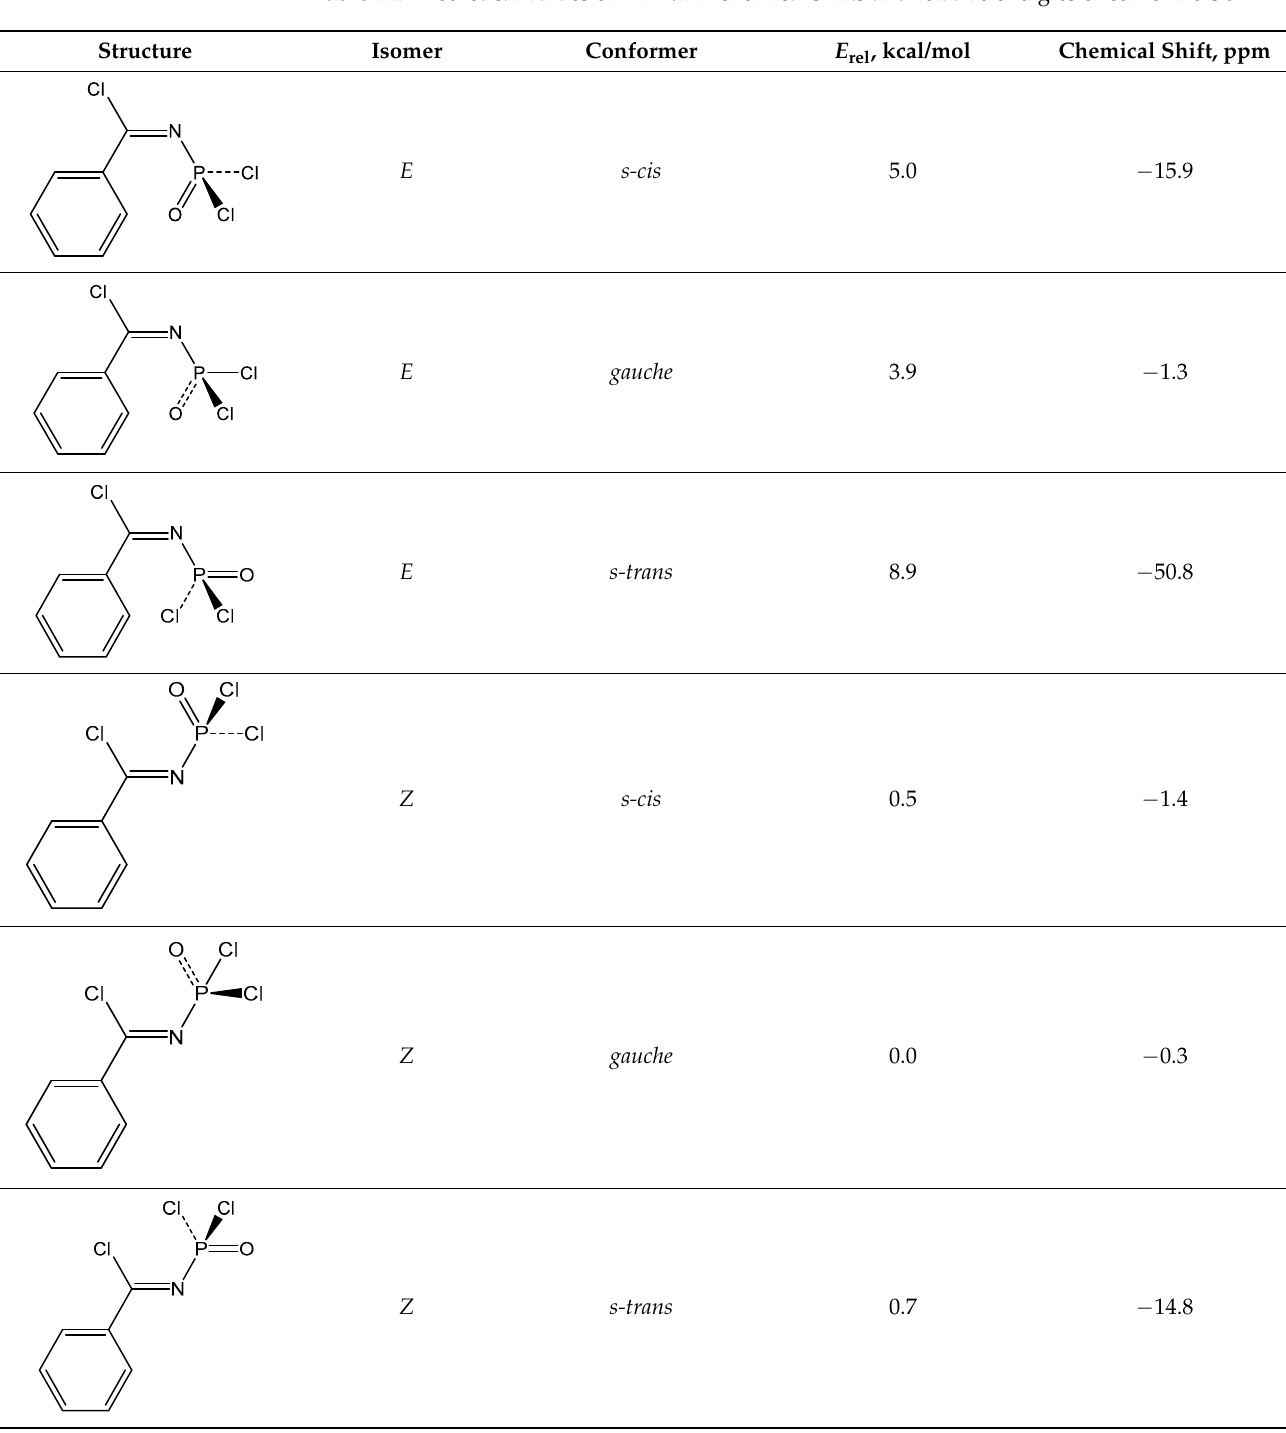
Table 12. Theoretical values of 31 P NMR chemical shifts and relative energies of conformers 37 .